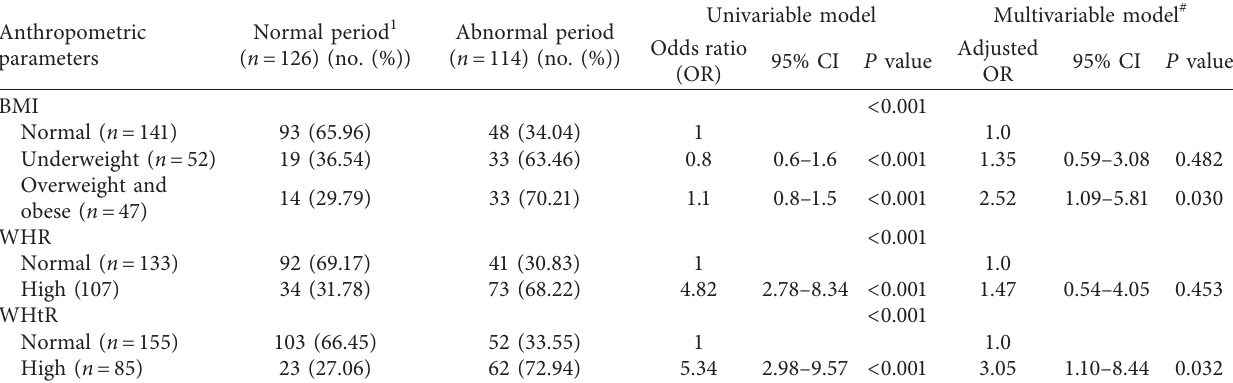
Table 4: Relation of anthropometric parameters with duration of the menstrual period by using binary logistic regression analysis. Anthropometric Normal period 1 parameters